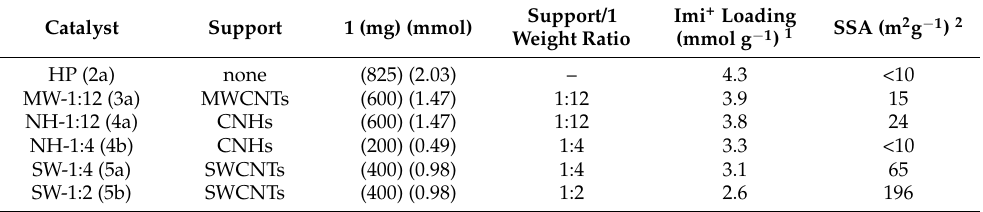
Table 1. Hybrid materials prepared with their imidazolium loading and specific surface area (SSA).